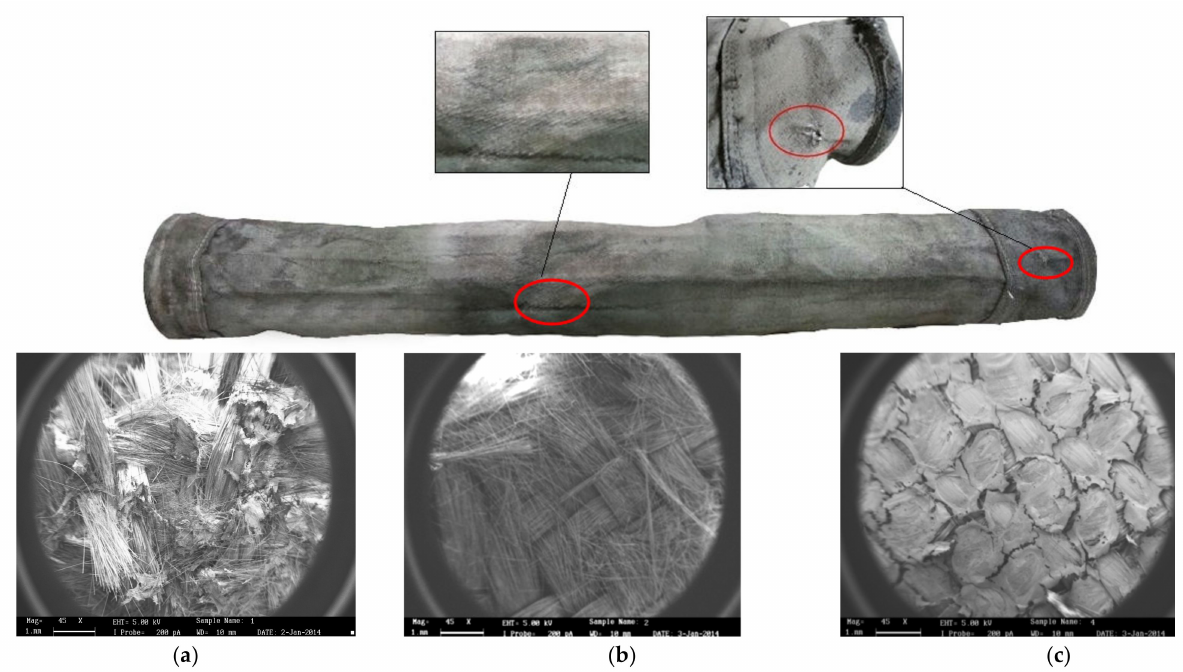
Figure 2. The wasted filter bags in our previous experiment. ( a ) SEM of bottom area. ( b ) SEM of middle area. ( c ) SEM of top